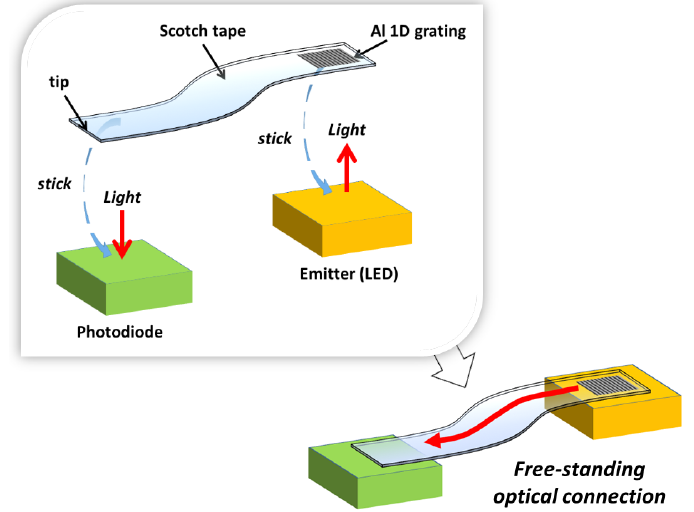
Figure 1. Schematics of the proposed rapid on-site establishment of an optical link between a vertical emitting device (an LED) and a vertical detecting device (a photodiode) through a flexible tape waveguide with an integrated aluminum one-dimensional (1D) grating coupler.